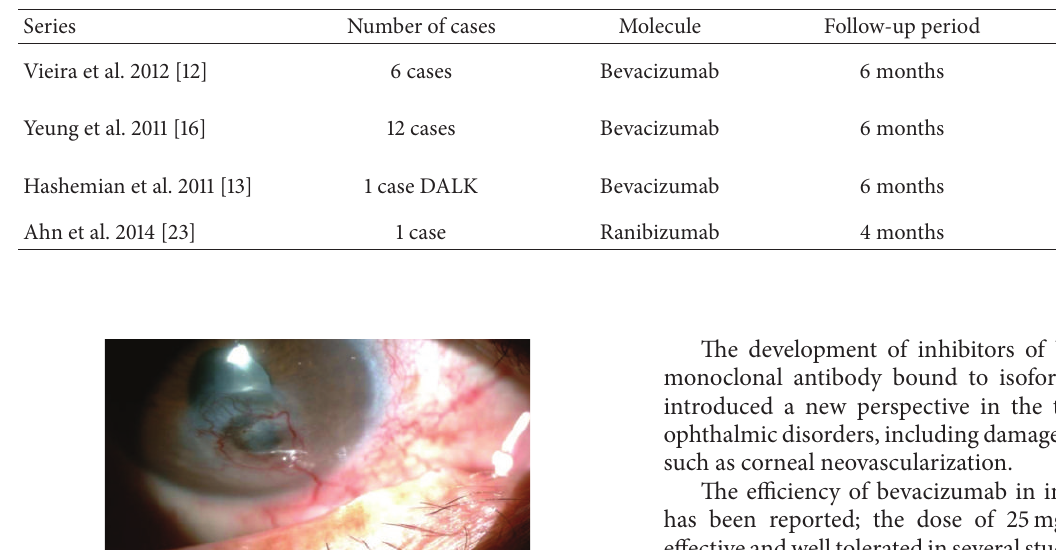
Table 2: Deep neovessels’ response to VEGF according to studies.